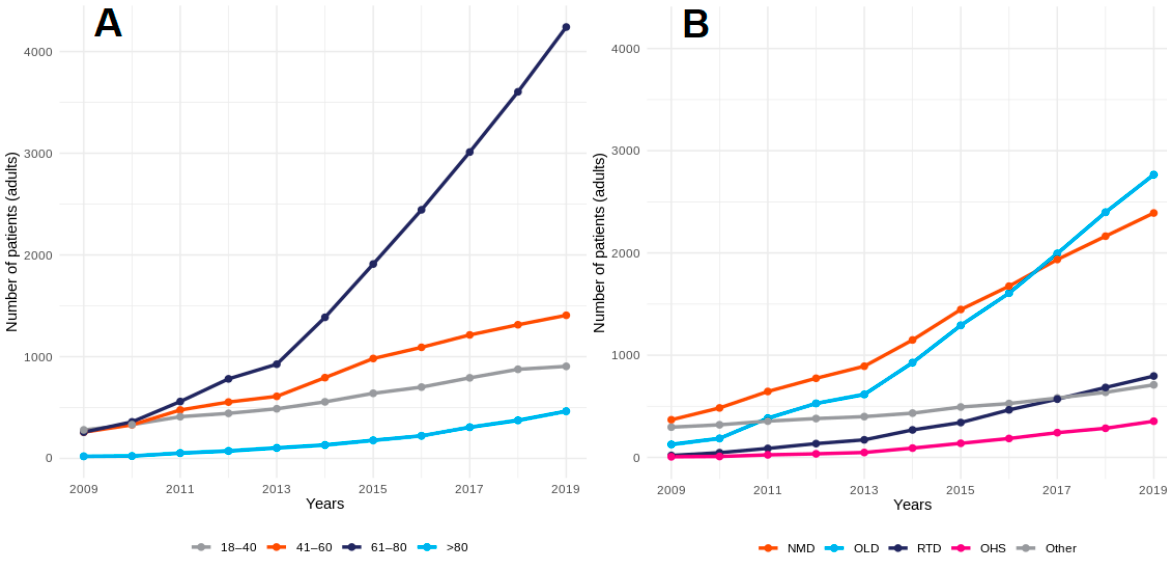
Figure 3. Increase in the number of adult HMV users throughout the years 2009–2019 ( A ) by age group and ( B ) by diagnostic